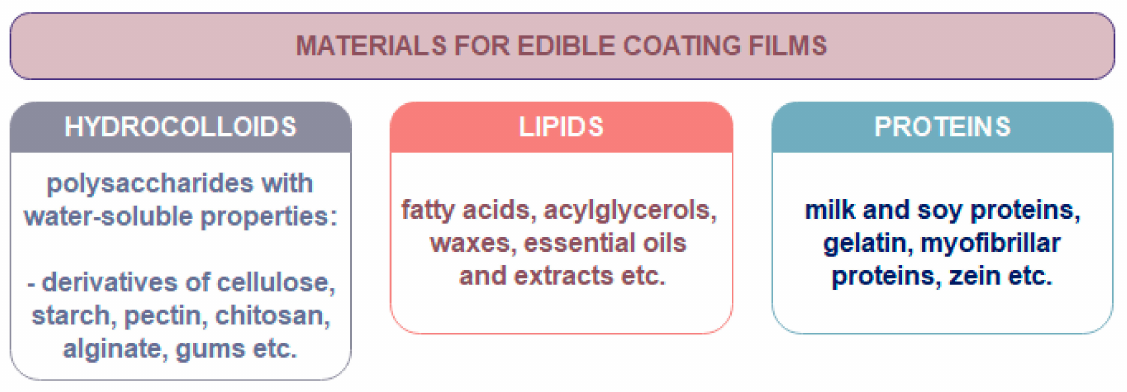
Figure 4. Materials used for production of edible coating films in food industry.